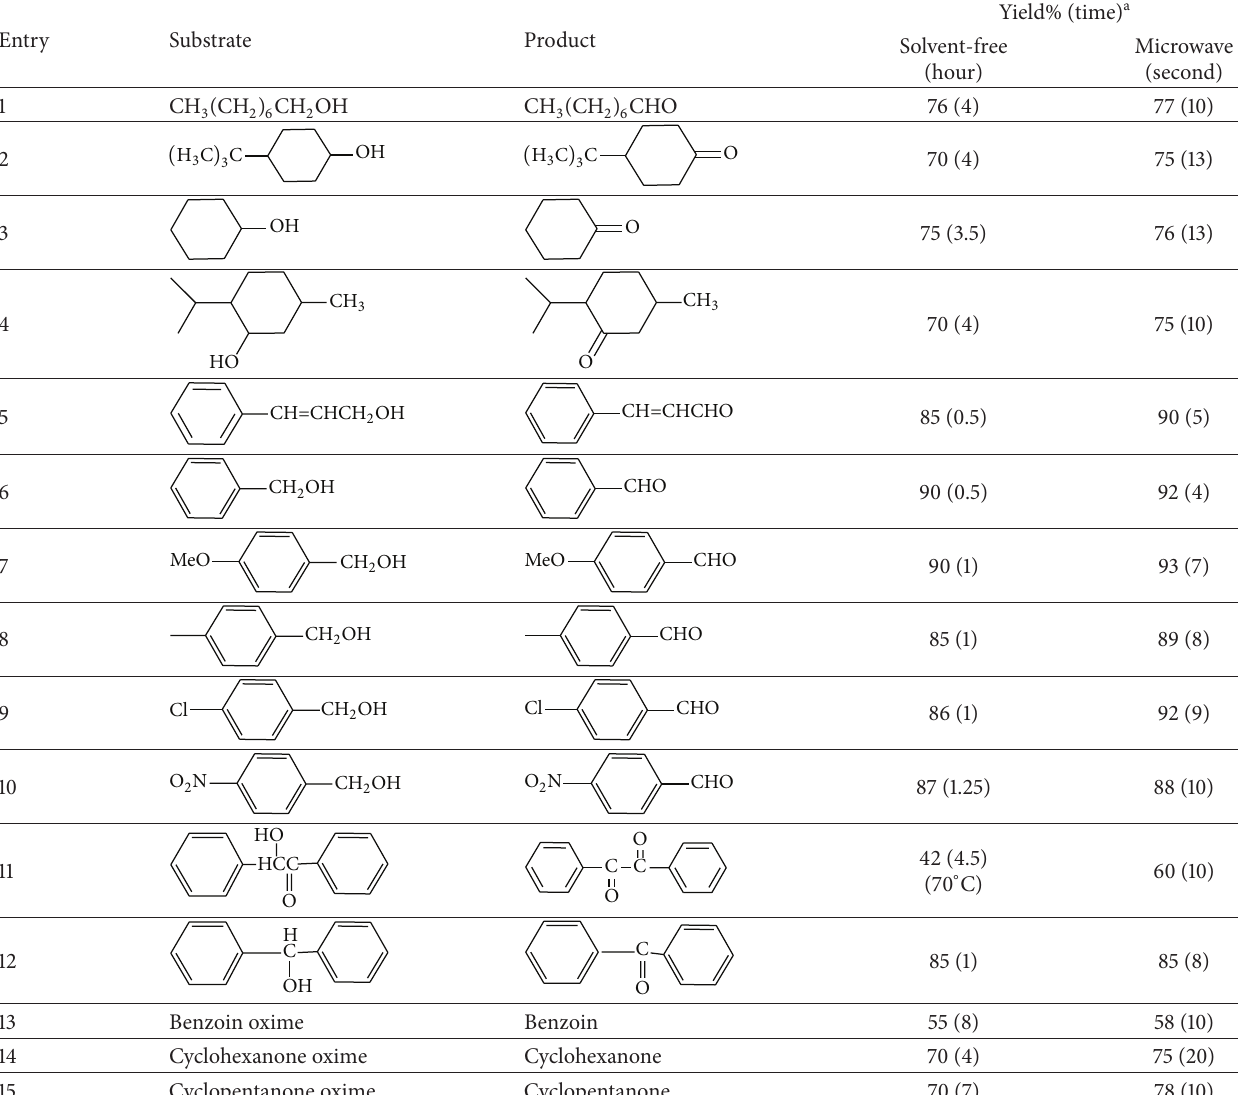
Table 3: The oxidation of alcohols and oximes with TMGFC under solvent-free conditions at room temperature and under microwave